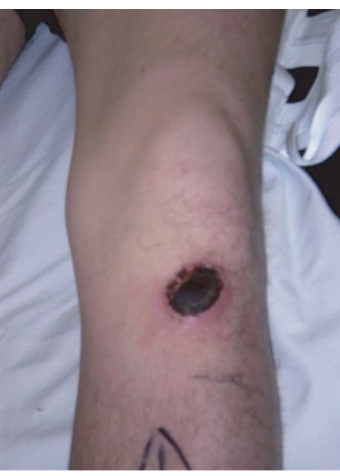
Figure 1: Skin burn over the anterior aspect of left leg.